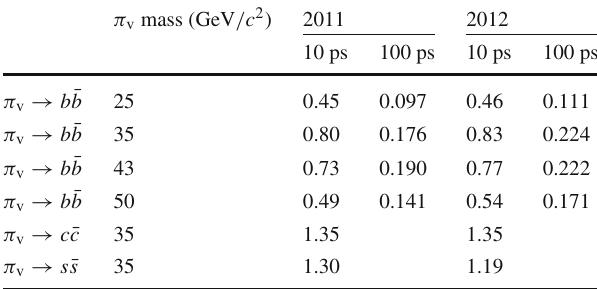
Table 1 Number of selected candidates per generated H 0 → π v π v event (efficiency) in percent for different π v → qq , q = b , c , s models for 2011 and 2012 data taking conditions, as derived from simulation. The relative statistical uncertainty on the efficiency due to the limited size of the simulated sample is less than a few